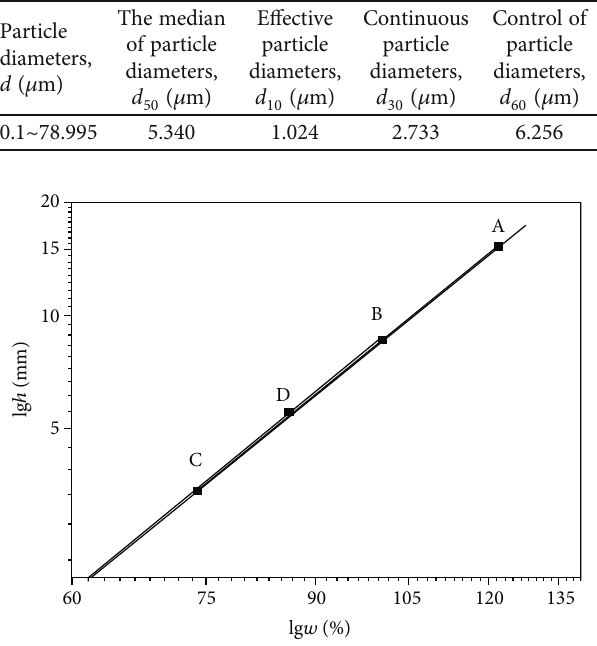
Figure 5: Relationship of cone sinking depth and water